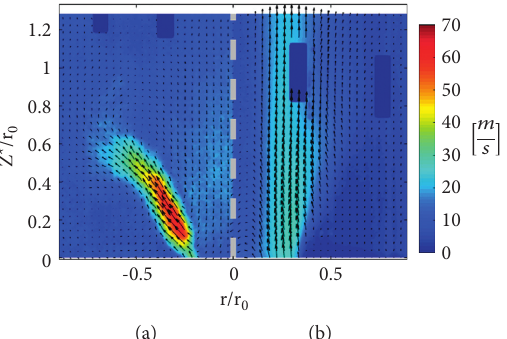
Figure 11: Velocity contour for phase 180 deg for no PIM (a) and PIM